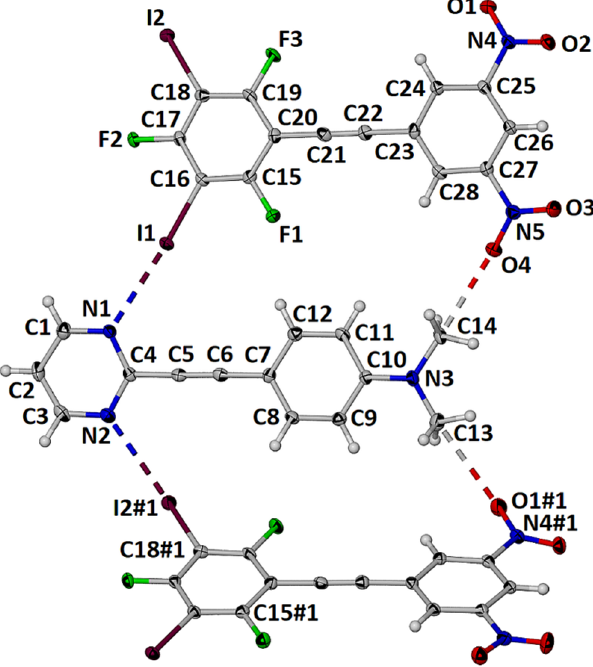
Figure 10. Asymmetric unit of the cocrystal 2 • 3 with displacement ellipsoids drawn at the 50% level. Halogen bonds and tetrel bonds shown as dashed lines.